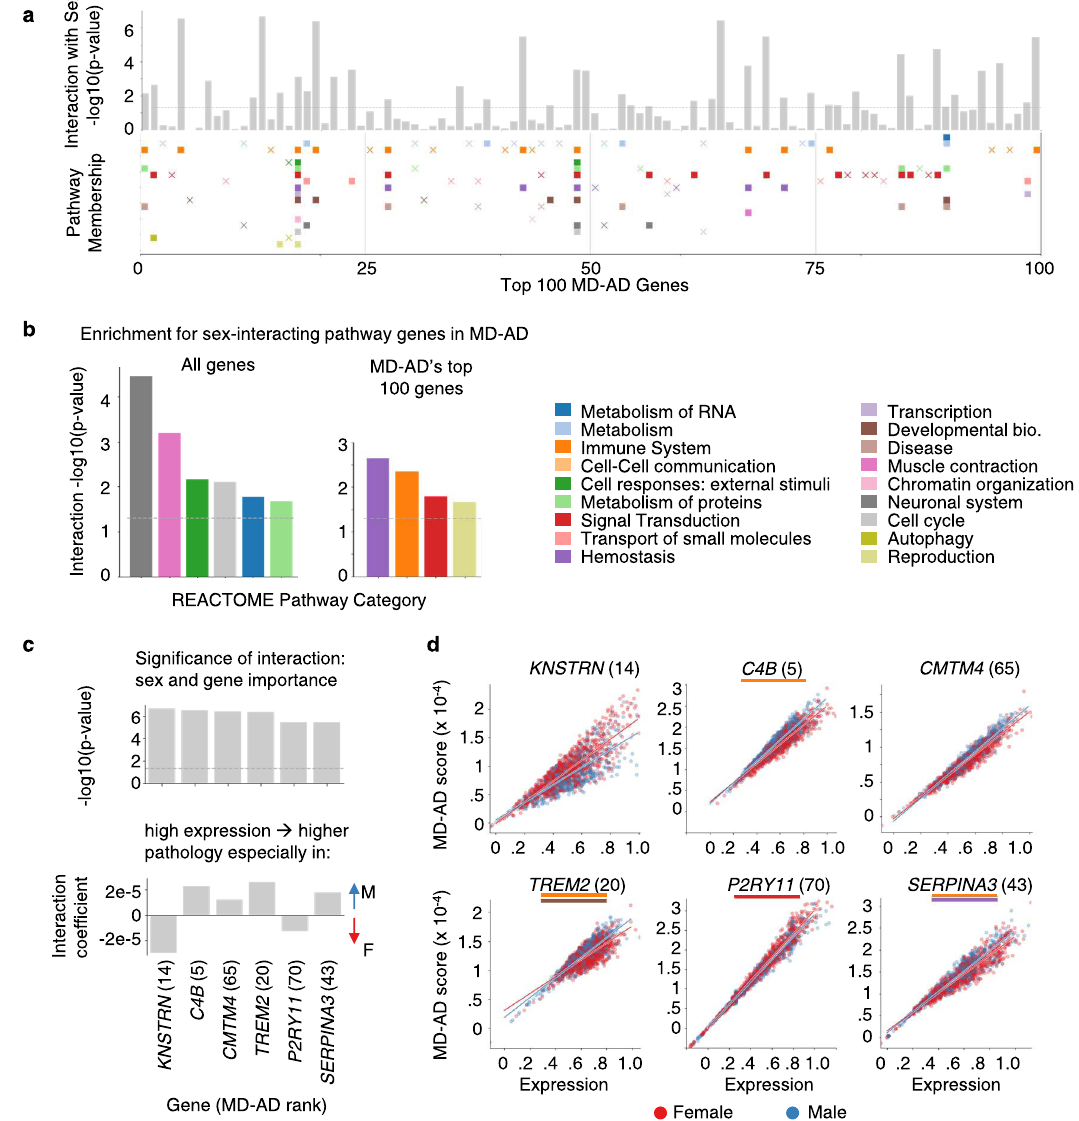
Fig. 5 MD-AD ’ s top genes and their interactions with sex. a For the top 100 MD-AD genes, we compute the signi fi cance of the interaction between expression and sex for its MD-AD score. The bars indicate the gene ’ s − log10( p value) of the interaction term with sex (after FDR correction), and pathway categories each gene belongs to are indicated below. A fi lled square indicates that the gene signi fi cantly interacts with sex ( p < 0.05 after FDR correction), and an “ x ” marker indicates that it does not. b For genes with signi fi cant sex interactions, we compute the signi fi cance of the overlap between REACTOME category genes and sex-differential genes among Left: all genes, and right: the top 100 MD-AD genes only. c For the top 100 MD-AD genes, we identify the genes with the most signi fi cant sex interaction for MD-AD scores. We show the signi fi cance of the interaction (top) and the interaction coef fi cients (bottom) for the top six most sex-differential genes. Each gene ’ s MD-AD rank is indicated in their x axis labels. d For the top six most sex-differential top 100 MD-AD genes, we display scatter plots of expression by MD-AD score, coloring each sample by sex of the